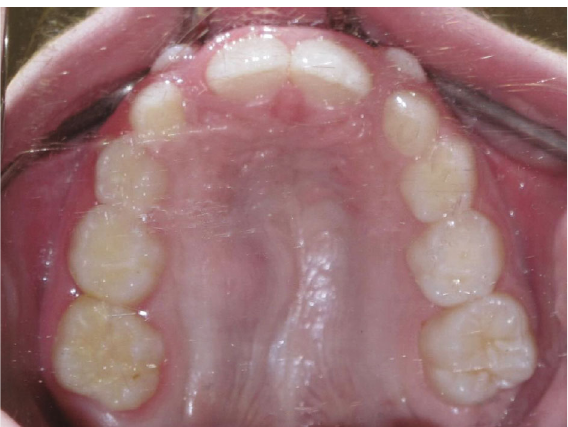
Figure 2: Intraoral photograph of the hard palate. Subtle swelling of the right hard palate with normal overlaying